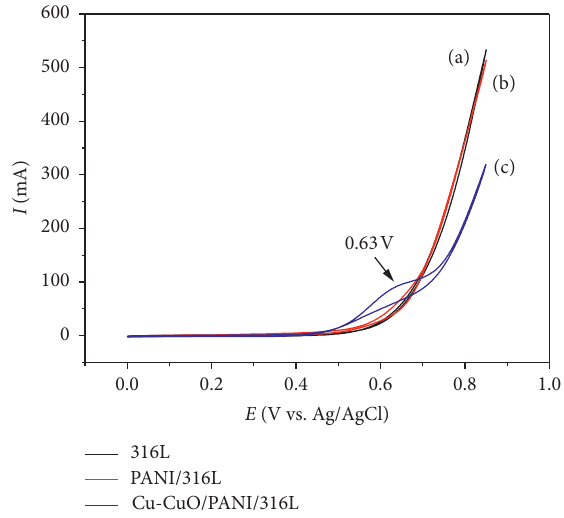
Figure 7: Comparison of CV curves of 316L (a), PANI/316L (b), and Cu-CuO/PANI/316L (c) electrodes measured in 5 mM glucose in 0.1M NaOH solution with scan rate 100mV/s.